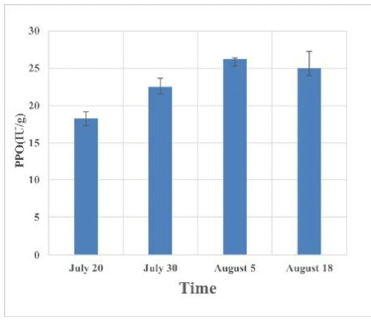
Table 3. Measuring polyphenol oxidase in host leaves at different times of injury. Time